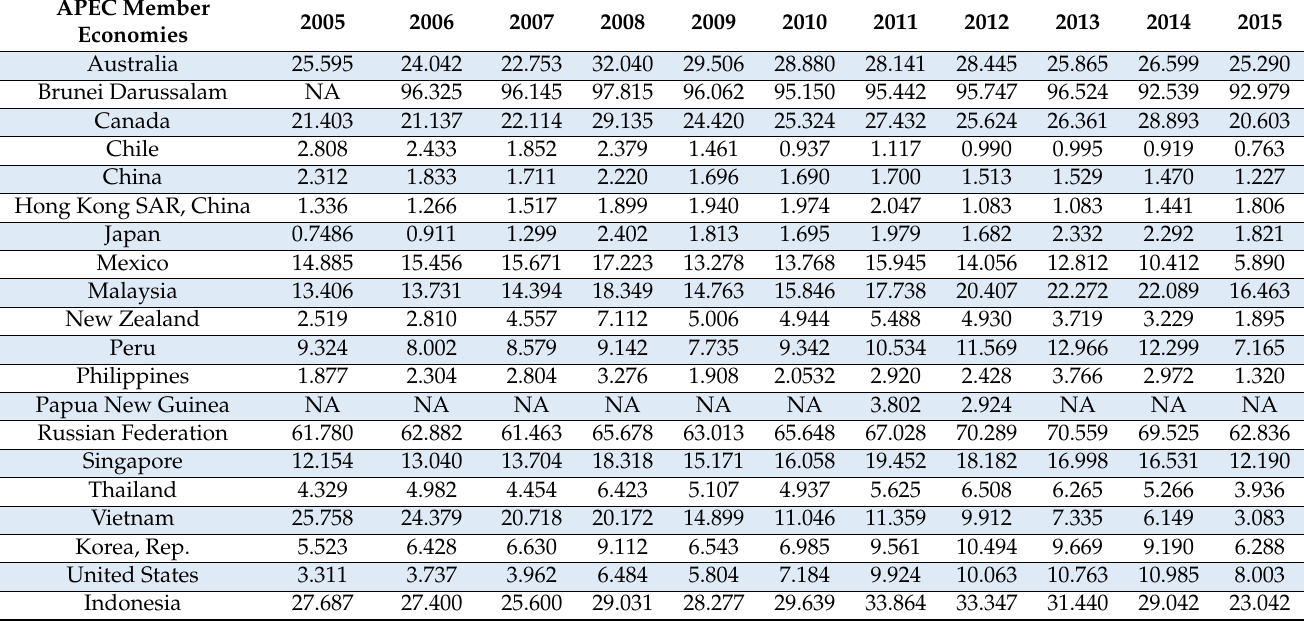
Table A3. Fuel exports (% of merchandise